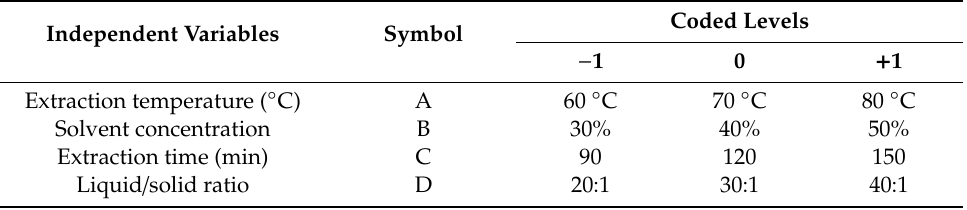
Table 1. Coded and actual levels of independent variables used in the